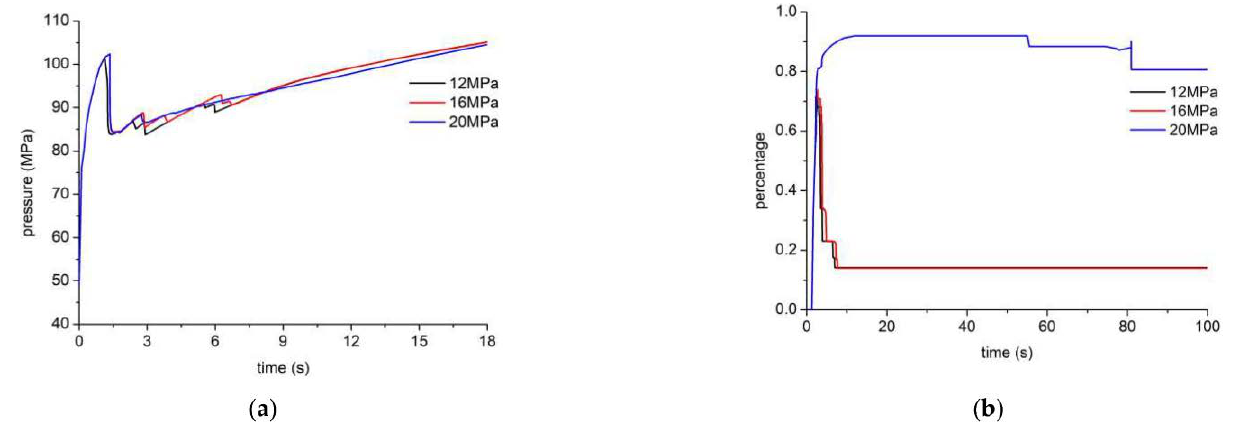
Figure 7. Fracture parameters under different bedding shear strengths: ( a ) injection pressure and ( b ) ratio of tensile